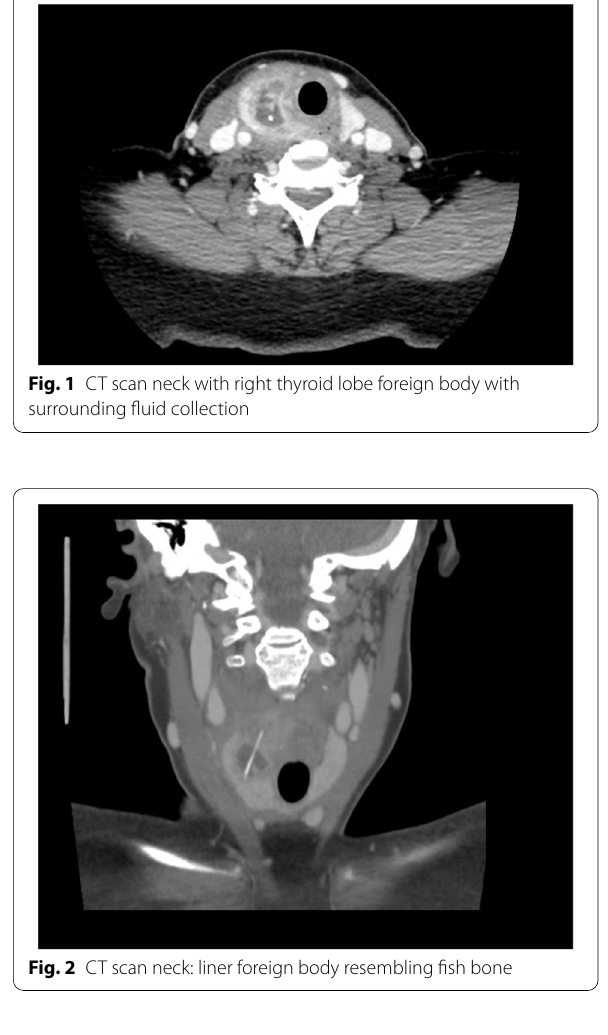
Fig. 4 Gross appearance of fish